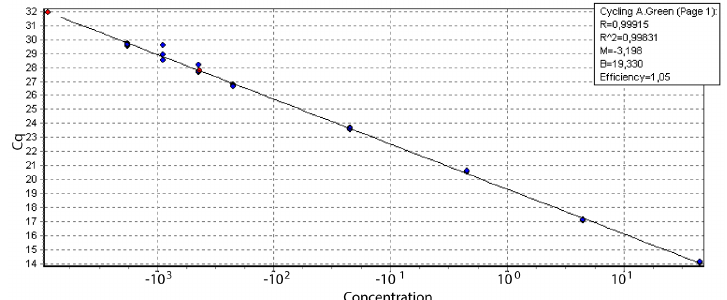
Figure 4. PCR Quantification cycle (Cq) vs. DNA concentration of known amounts (45, 4.5, 0.45, 0.045, 0.0045,